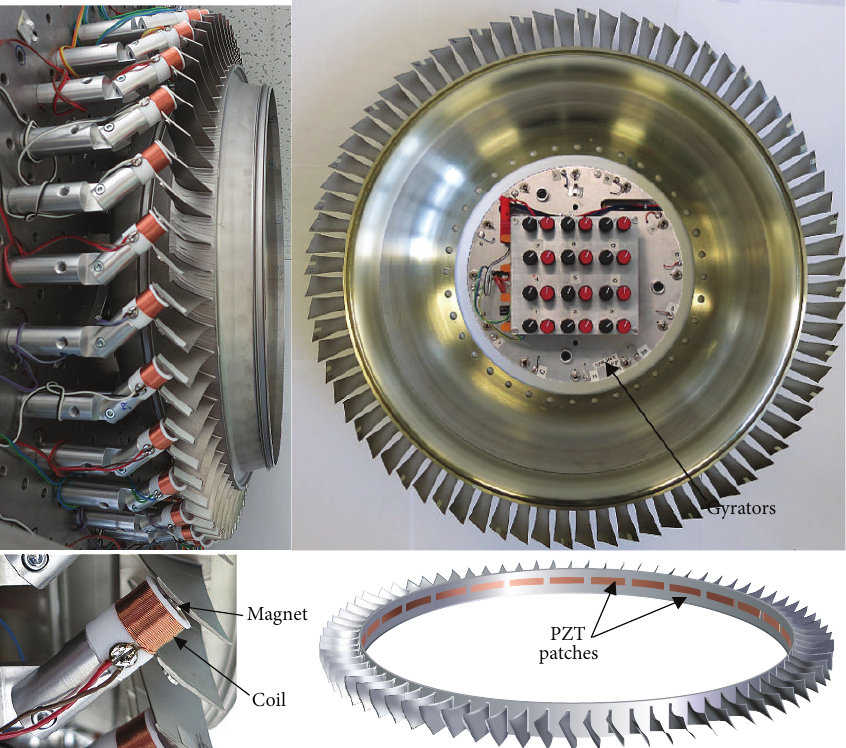
Figure11:Experimentalsetup:bladeddrumwith76bladesequippedwith28PZTpatchesgluedontheinnersideofthedrum.28independent gyrator circuits are used to provide synthetic inductors. 76 small permanent magnets are glued at the tip of the blades and 38 of them are used with (noncontact) voice coil actuators to provide a wide range of excitations to the structure.